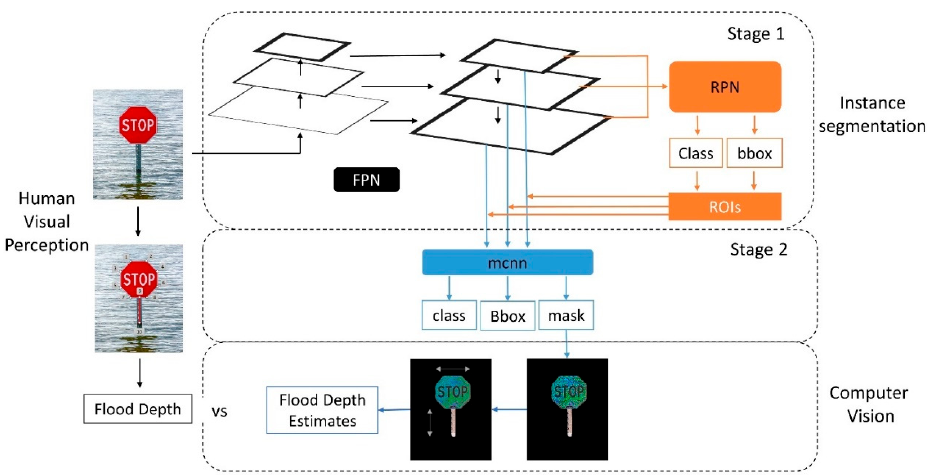
Figure 1. Overall architecture of